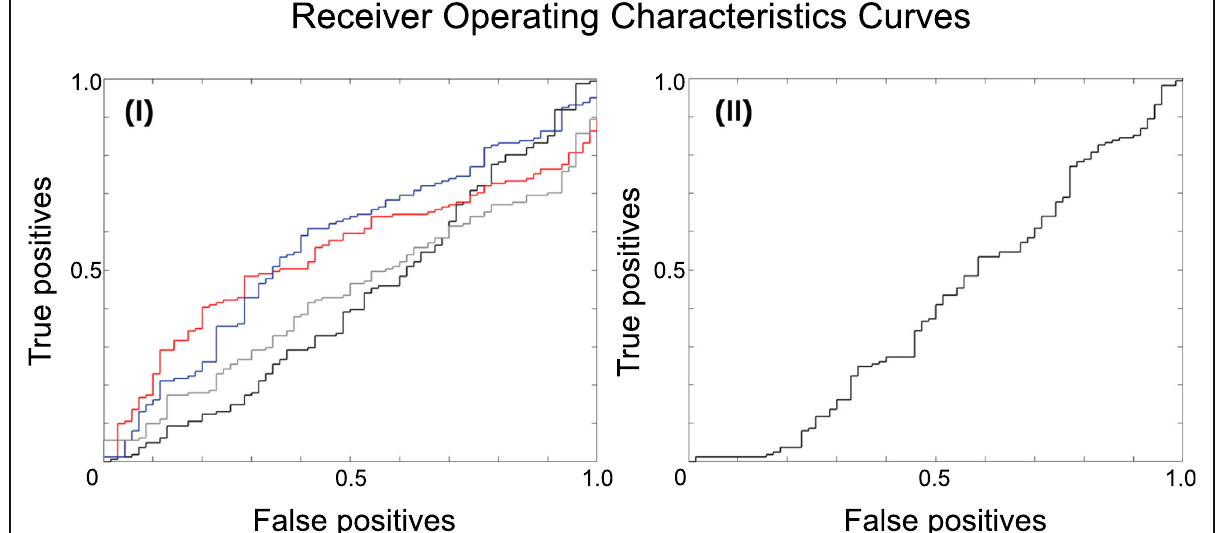
Fig. 1 ROCs for (I) FA (red), MD (black), RD (blue), and AD (grey) each as a single modality (bSVM) and (II) as concatenated modalities (MKL). Based on our results, the ROCs are indicating no substantial diagnostic value. Further, the concatenation of DTI modalities yields no additional information for this classification problem